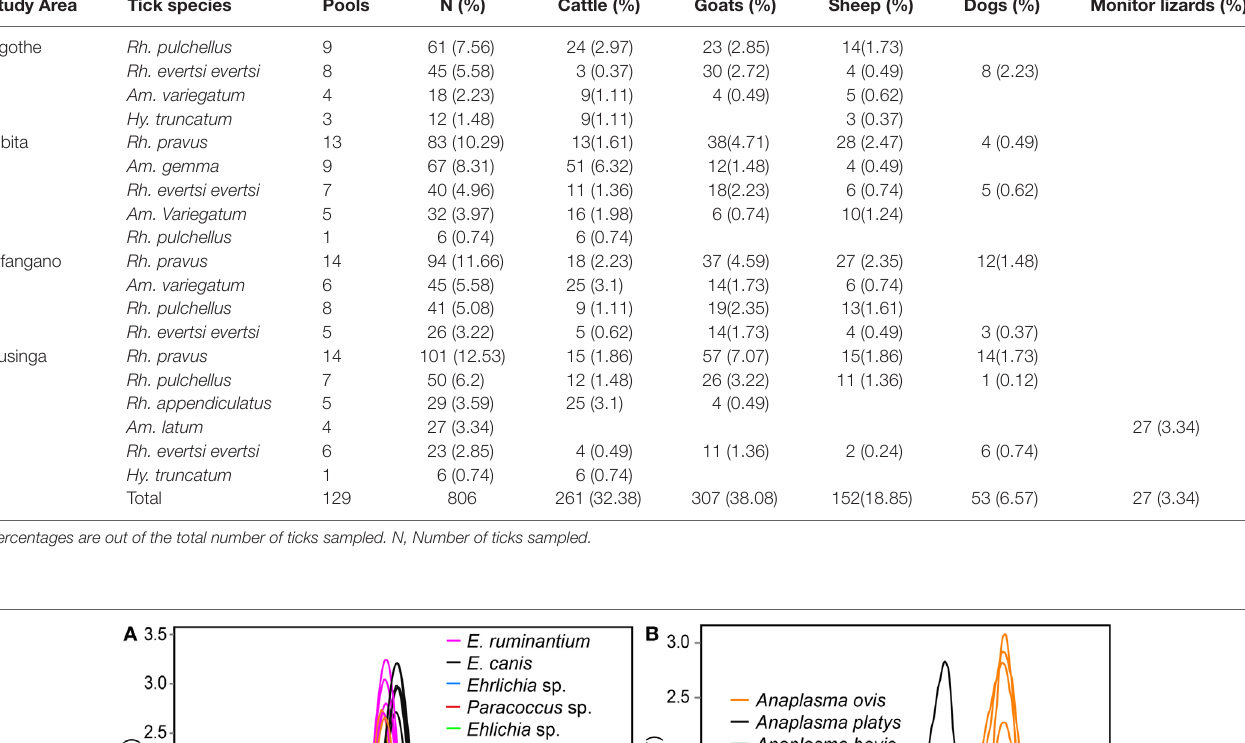
TaBle 3 | Ticks sampled from different host species in four study areas of homa Bay county. study